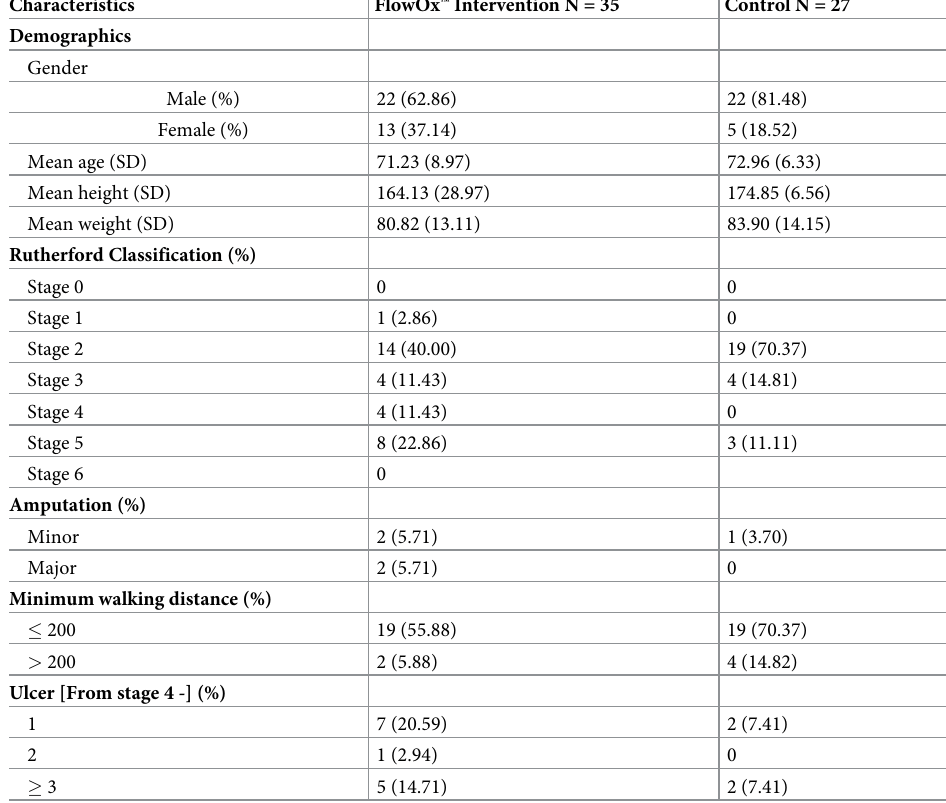
Table 4. Demographics of study population (generated from two primary data sources).